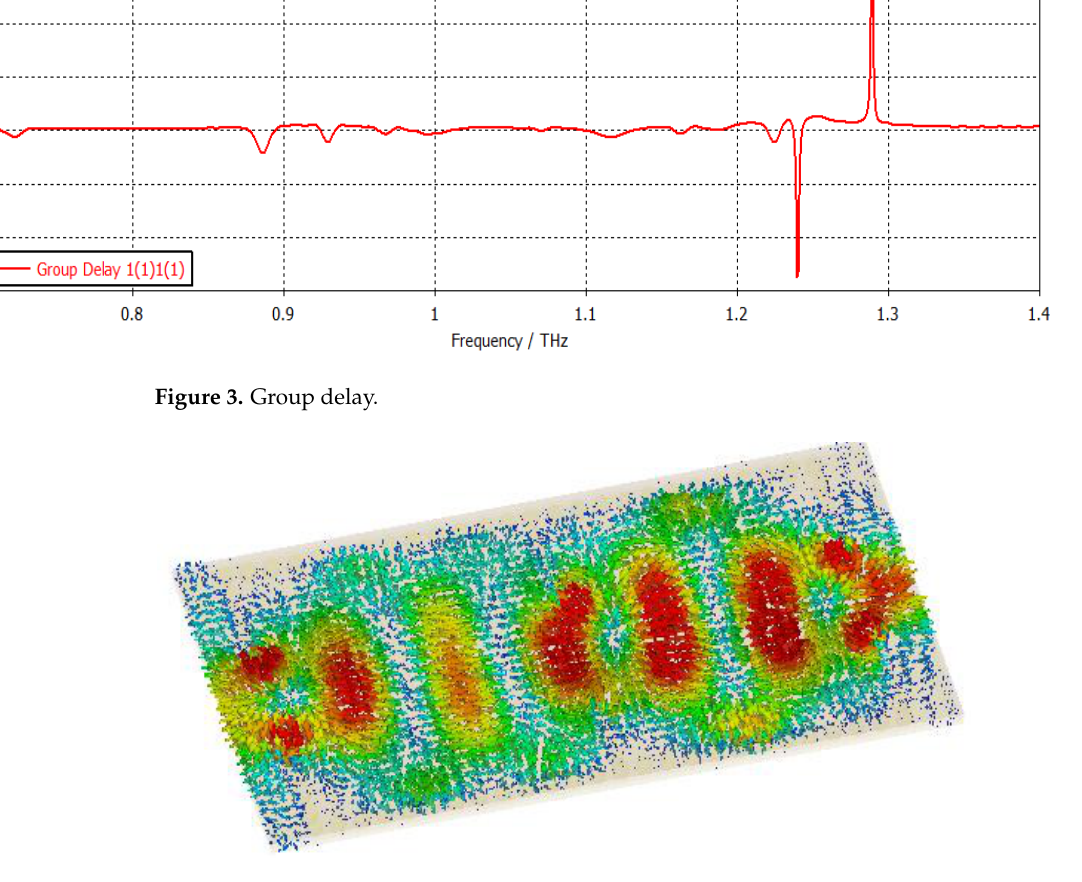
Figure 4. Current distribution.